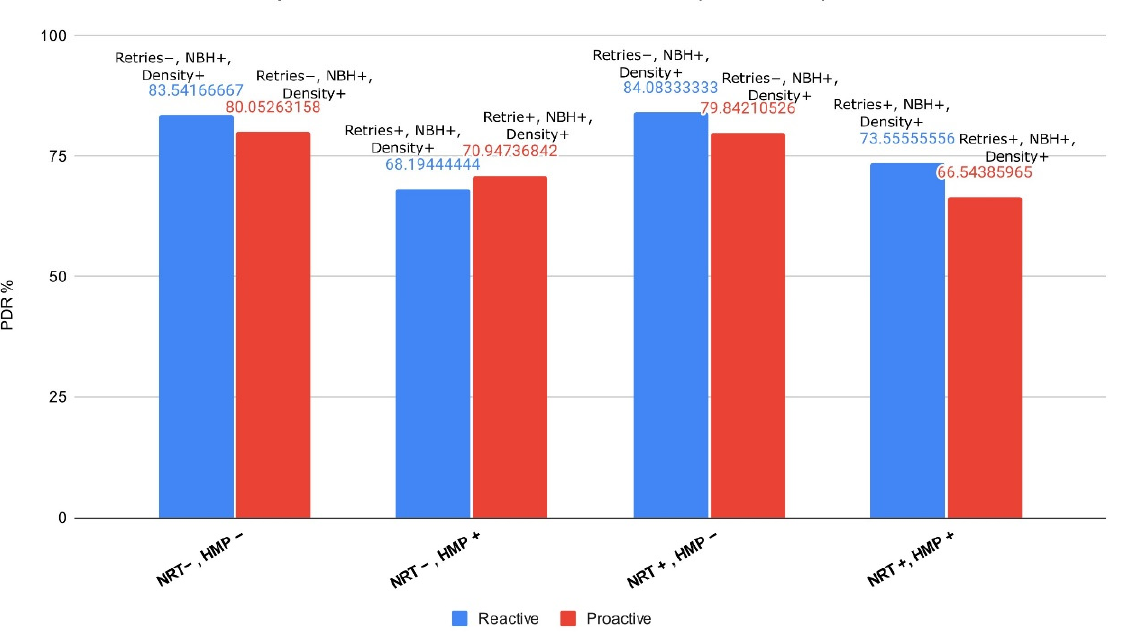
Figure 6. PDR Comparison between the best scenarios from the combination of values of the combined factor e13.